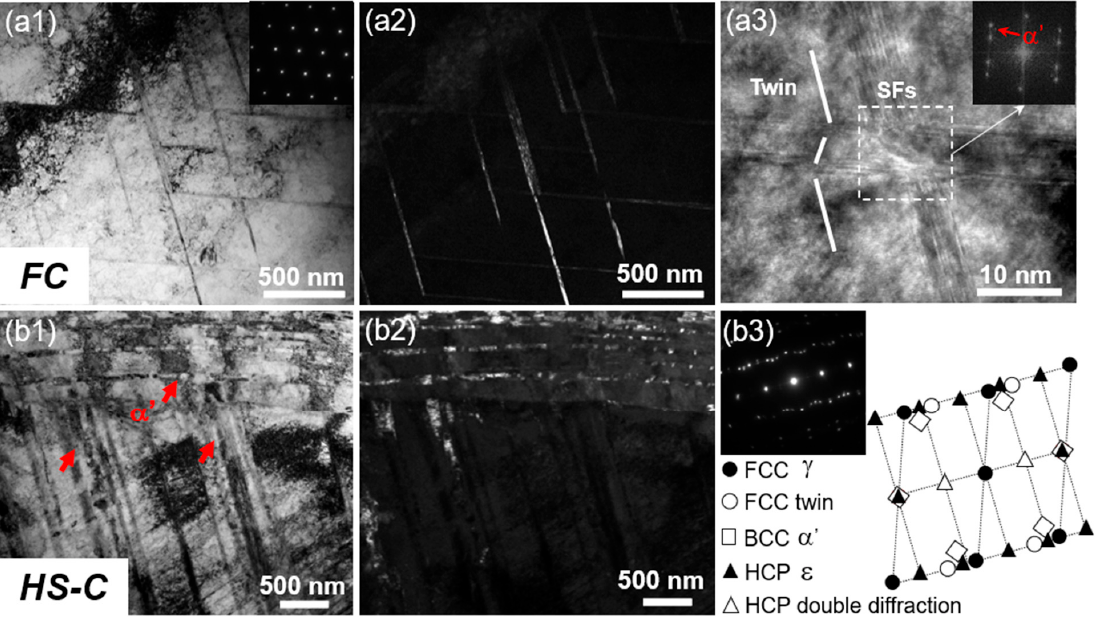
Figure 9. TEM microstructures of tensile samples. ( a1 , a2 ) Microstructures of freestanding center (FC) samples after tensile deformation; ( a3 ) high-resolution TEM image showing the martensite in FC sample after deformation; ( b1 , b2 ) microstructures of HS sample after tensile testing; and ( b3 ) diffraction pattern of ( b1 ). The red arrows in (a3) and (b1) indicate the α′ -martensite.